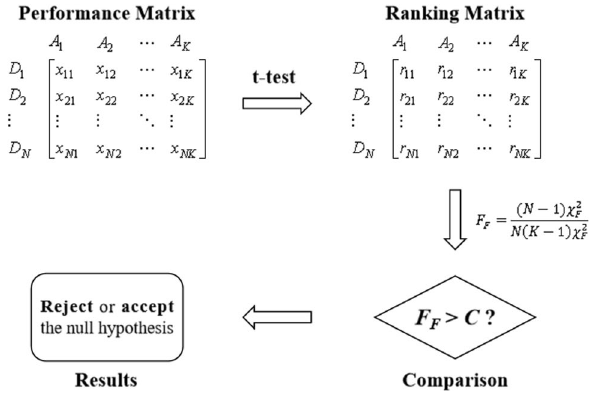
Fig. 2 The framework of t-Friedman